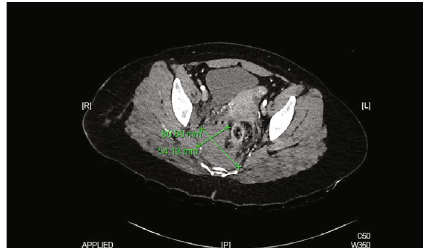
Figure 2: Hematoma in pelvic CT.